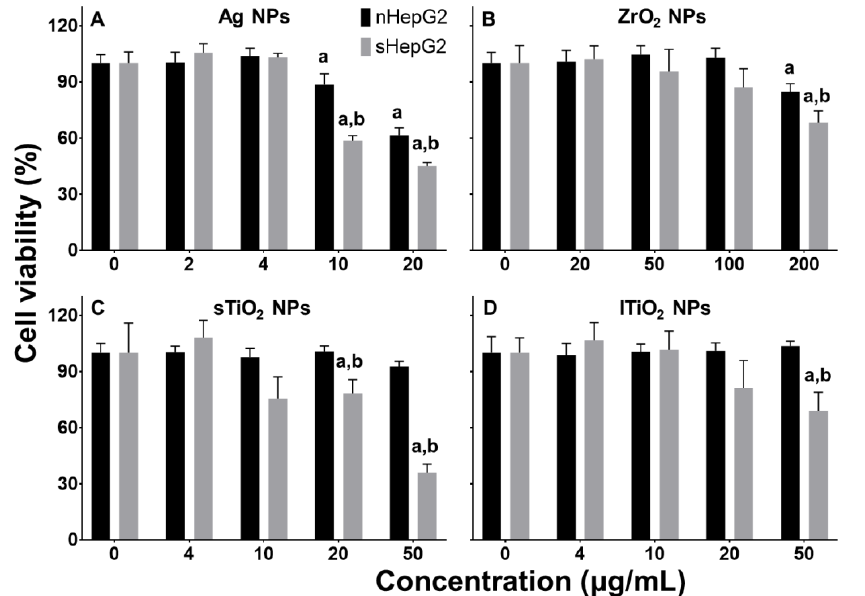
Figure 3. Susceptibility of steatotic hepatocytes to cytotoxicity in response to MNP exposures. ( A – D ) Dose-dependent viability of non-steatotic and steatotic HepG2 cells treated with Ag NPs ( A ), ZrO 2 NPs ( B ), and TiO 2 of different sizes ( C , D ). Data are shown as means ± s.d., n = 5. a p < 0.05, compared with vehicle control. b p < 0.05, compared with viability of nHepG2 cells with the same